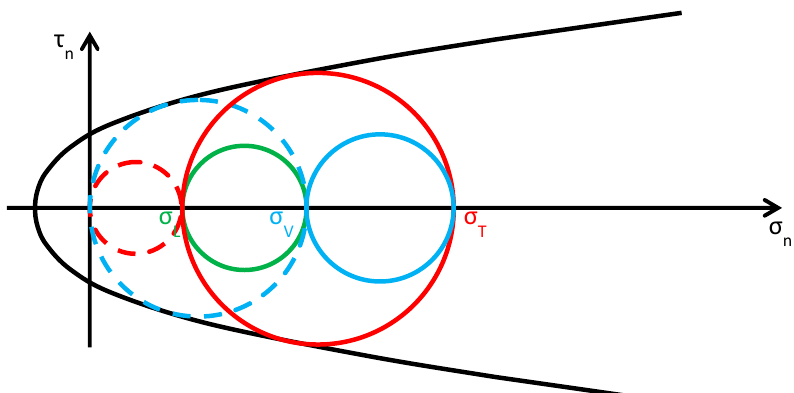
Figure 19. First limit condition after the application of the retrofitting system (Mohr’s circles before retrofitting in dashed lines, for comparison).